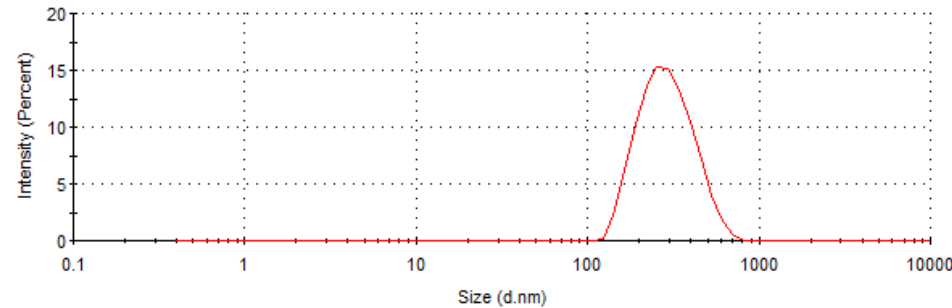
Figure 1. Size distribution by intensity of PDLLA NPs obtained by DLS measurements.